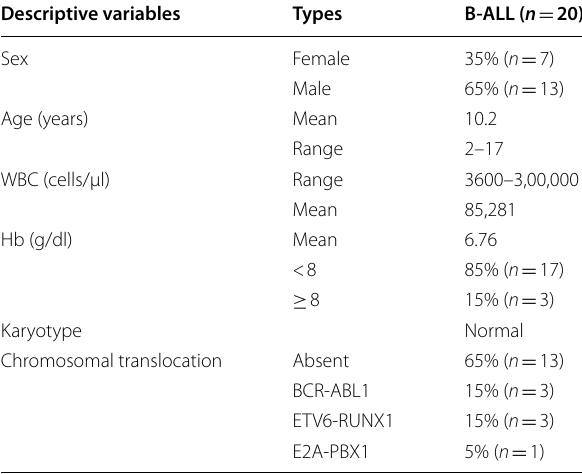
20) included in the